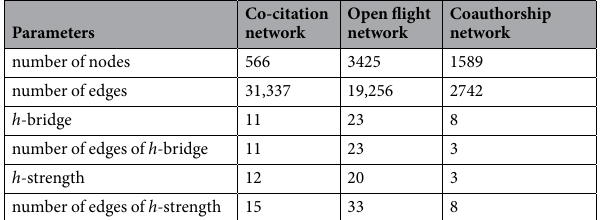
Table 1. The sample data with network parameters. The number of edges with weights higher than or equal to the h -strength is greater than the h - strength because there are many nodes with weights identical to the h - strength.